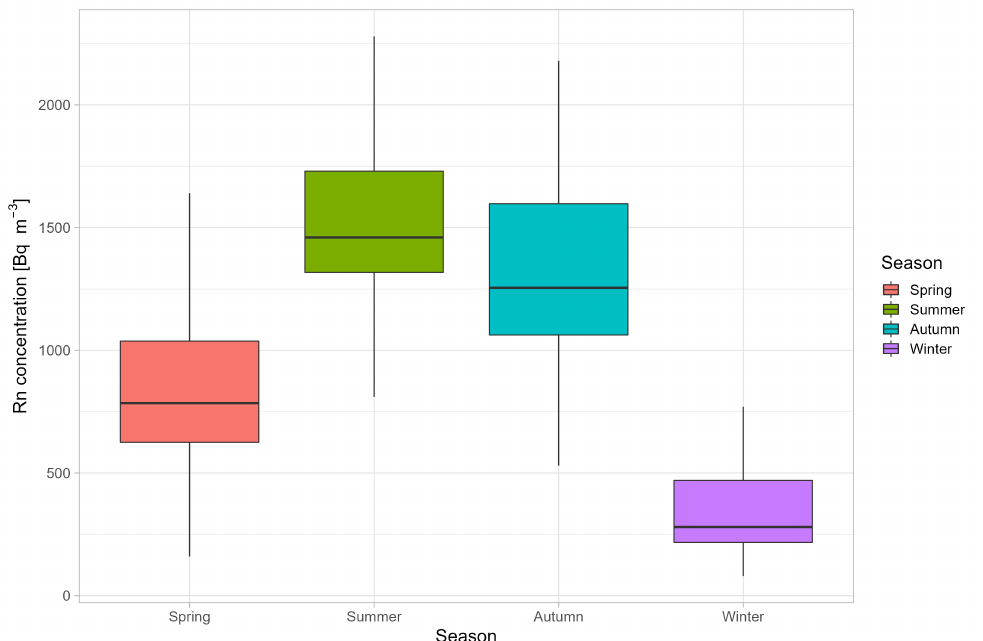
Figure 3. Box plot of seasonal radon concentration for all measurement points.